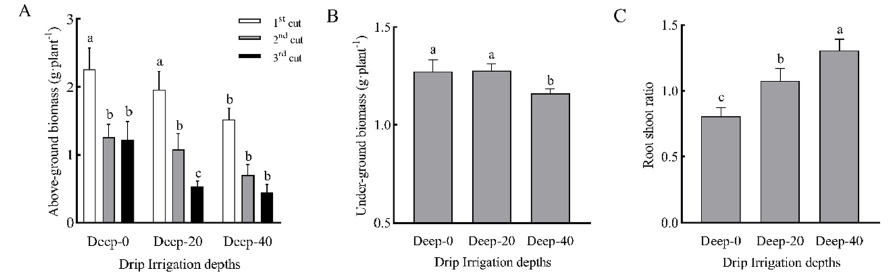
Figure 4. Biomass allocation of alfalfa plants under three drip irrigation depths. ( A ) Aboveground biomass, ( B ) belowground biomass, and ( C ) root:shoot ratio. Lower ‐ case letters above bars indicate a significant difference ( p < 0.05, LSD test).